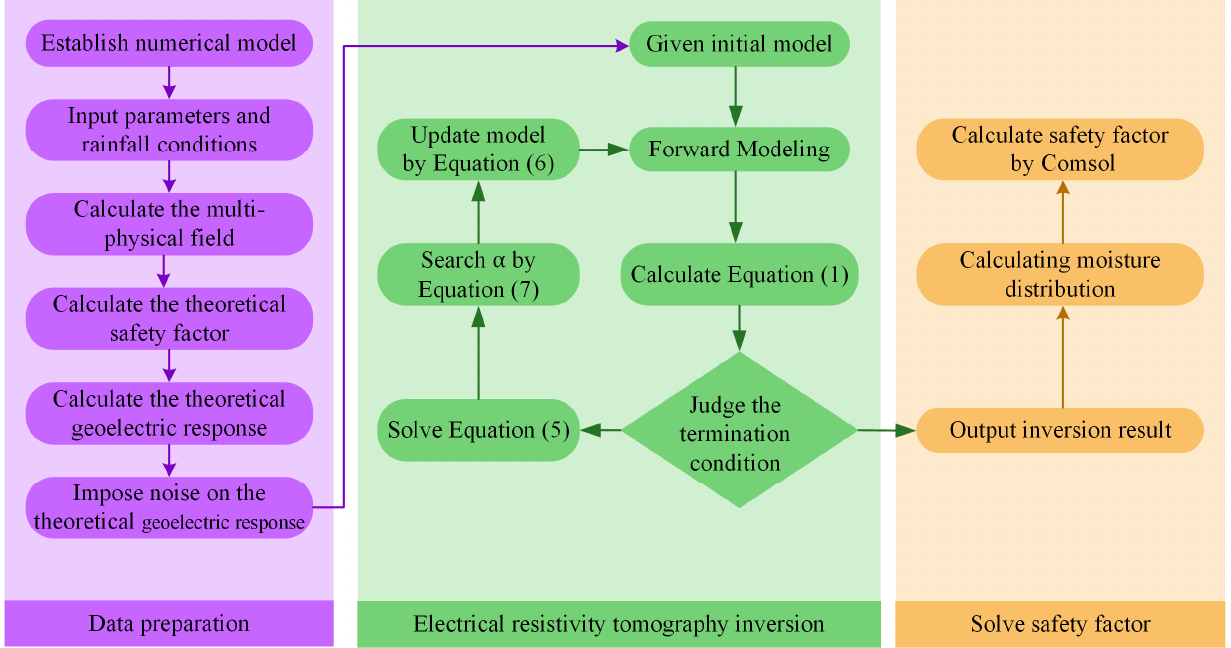
Figure 1. The proposed framework for calculating the evolution of landslides’ safety factors during rainfall.